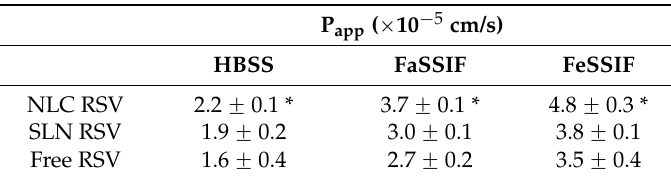
Table 2. Apparent permeability (P app ) of free resveratrol and resveratrol-loaded SLN or NLC for 4 h of transport across Caco-2 cell monolayer mimicking intestinal permeability